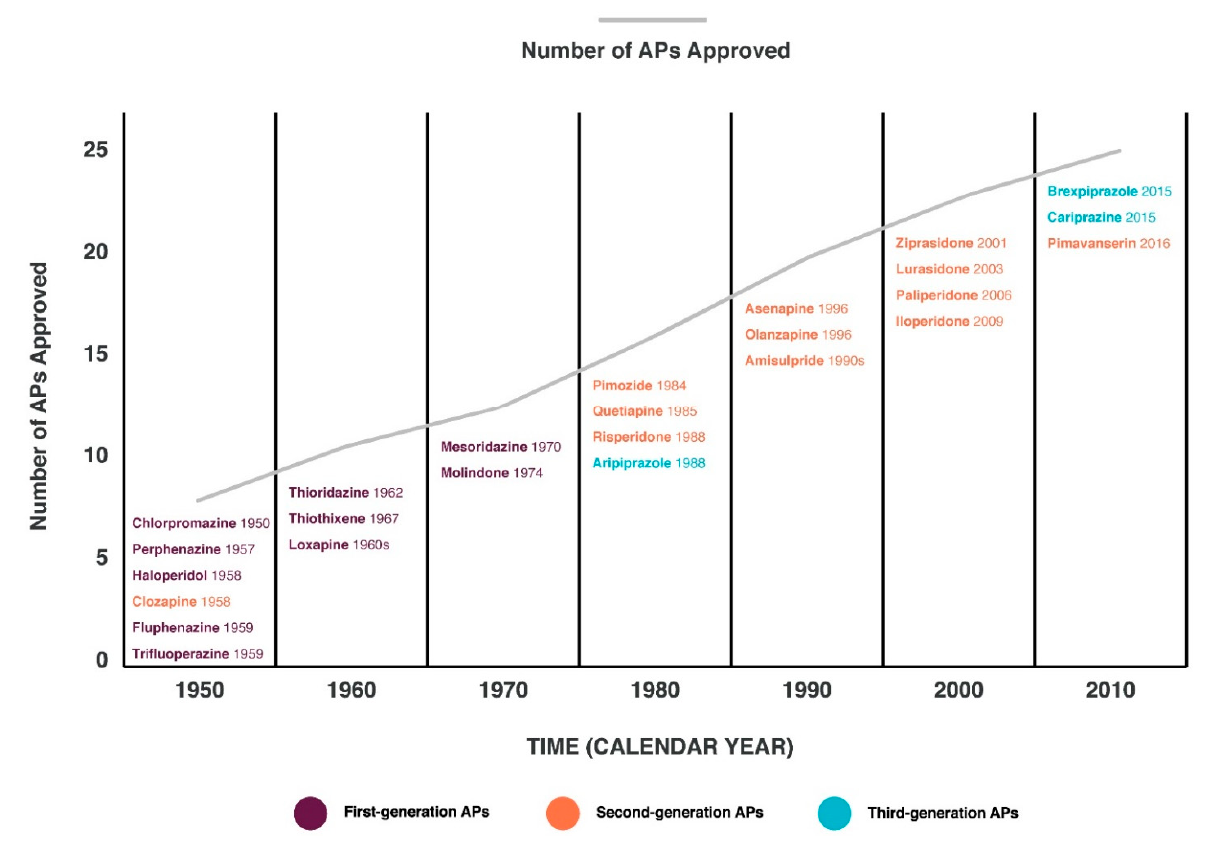
Figure 1. Timeline of antipsychotics (APs) approved by the Food and Drug Administration (FDA) [19].